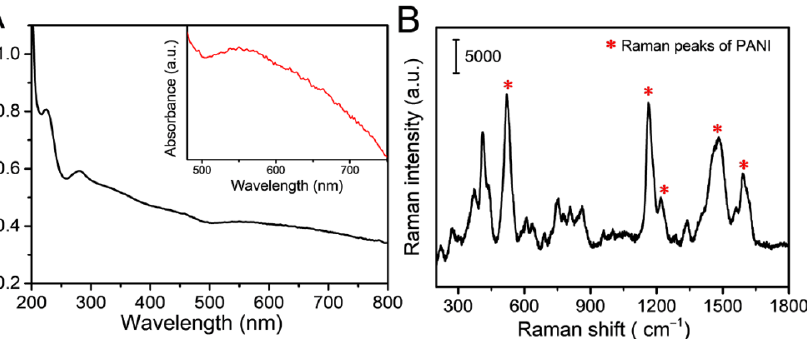
Figure 2. ( A ) UV–vis absorption spectra. ( B ) Raman spectrum of the pAuNCs (* indicated the Raman Figure 2. ( A ) UV – vis absorption spectra. ( B ) Raman spectrum of the pAuNCs (* indicated the Ra- man peaks of PANI). peaks of